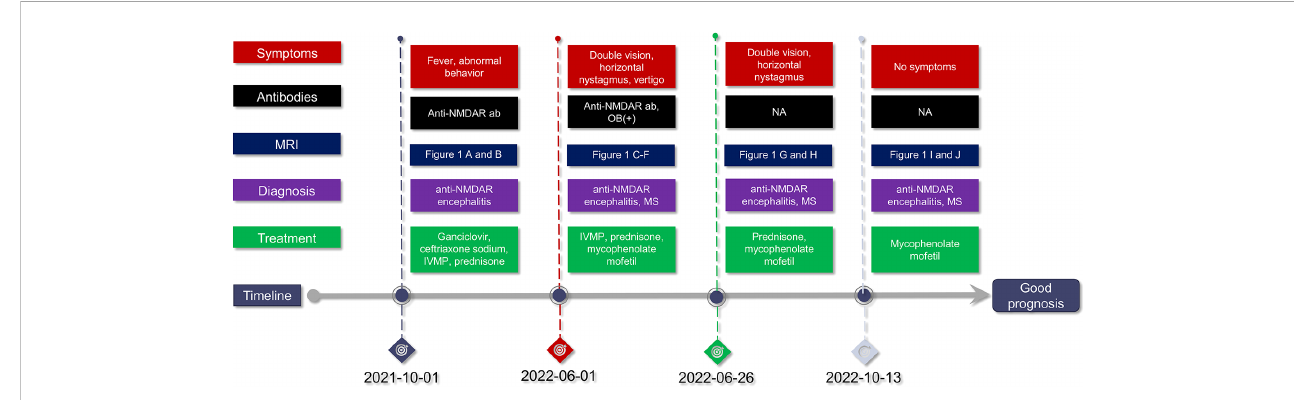
FIGURE 1 Disease duration in this case. Anti-NMDAR encephalitis, anti-N-methyl-D-aspartate receptor encephalitis; anti-NMDAR ab, anti-N-methyl-D-aspartate receptor antibody; MRI, magnetic resonance imaging; IVMP, intravenous methylprednisolone; MS, multiple sclerosis; NA, not available; OB, oligoclonal immunoglobulin